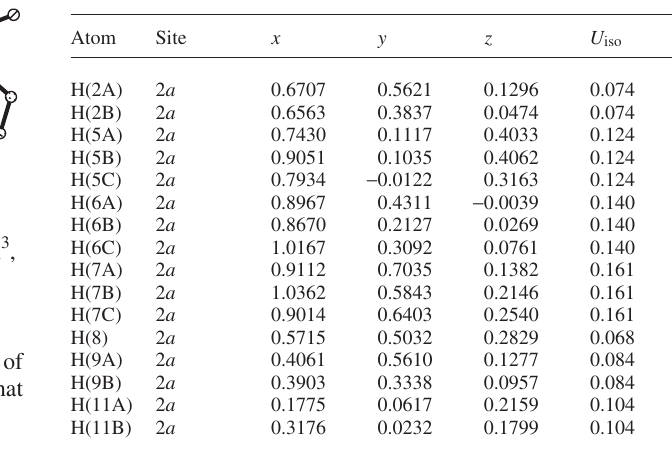
Table 2. Atomic coordinates and displacement parameters (in Å 2 )